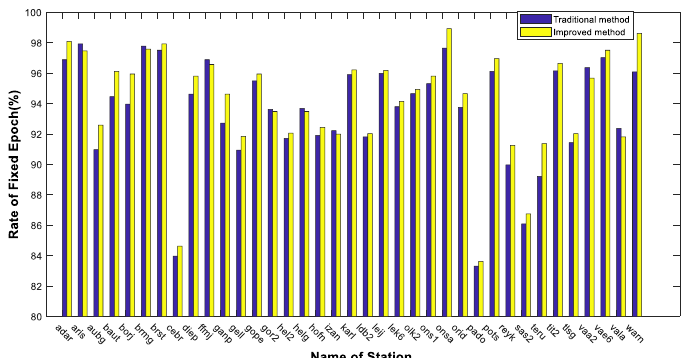
Figure 13. Rate of fixed epoch by using different methods in the dynamic model.